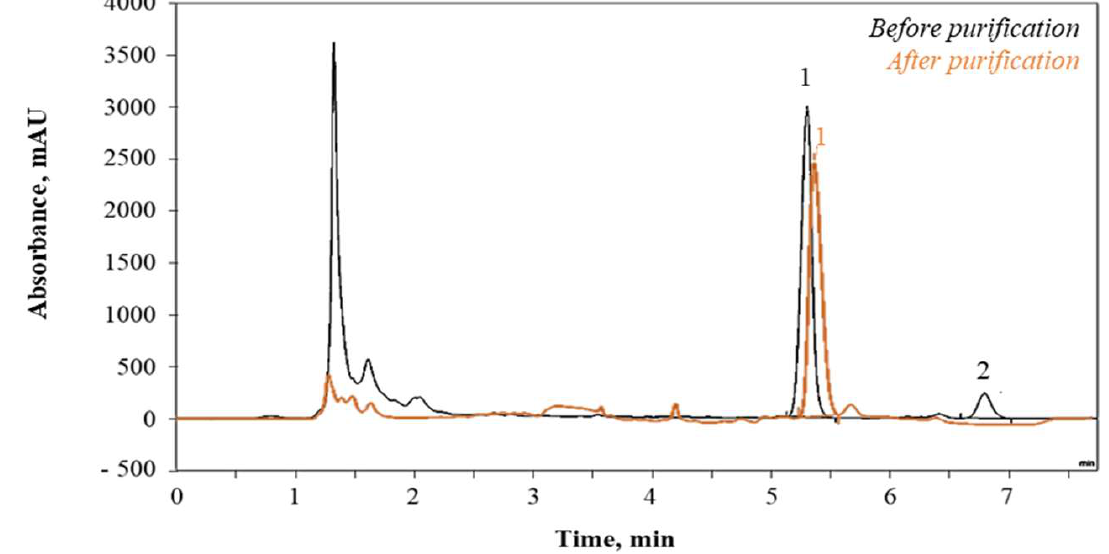
Figure 14. HPLC chromatogram of glucosinolates (1. sinigrin; 2. gluconapin) in the juice before and after the purification treatment with PA312LOH resin.